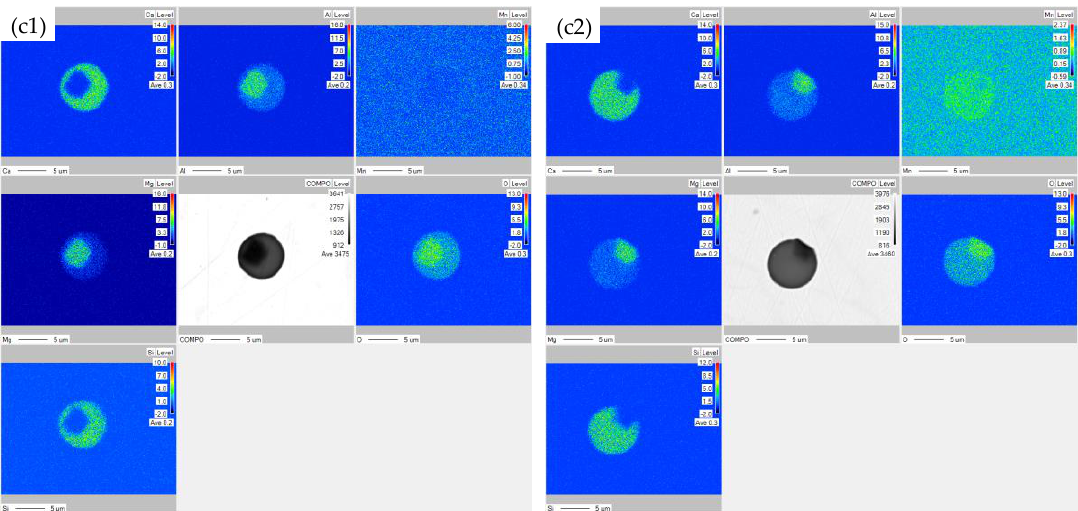
Figure 2. The WDS element maps of typical inclusions in samples: ( a ) typical inclusions at the end of AOD; ( b ) typical inclusions at the end of LF refining; ( c ) typical inclusions in the tundish.